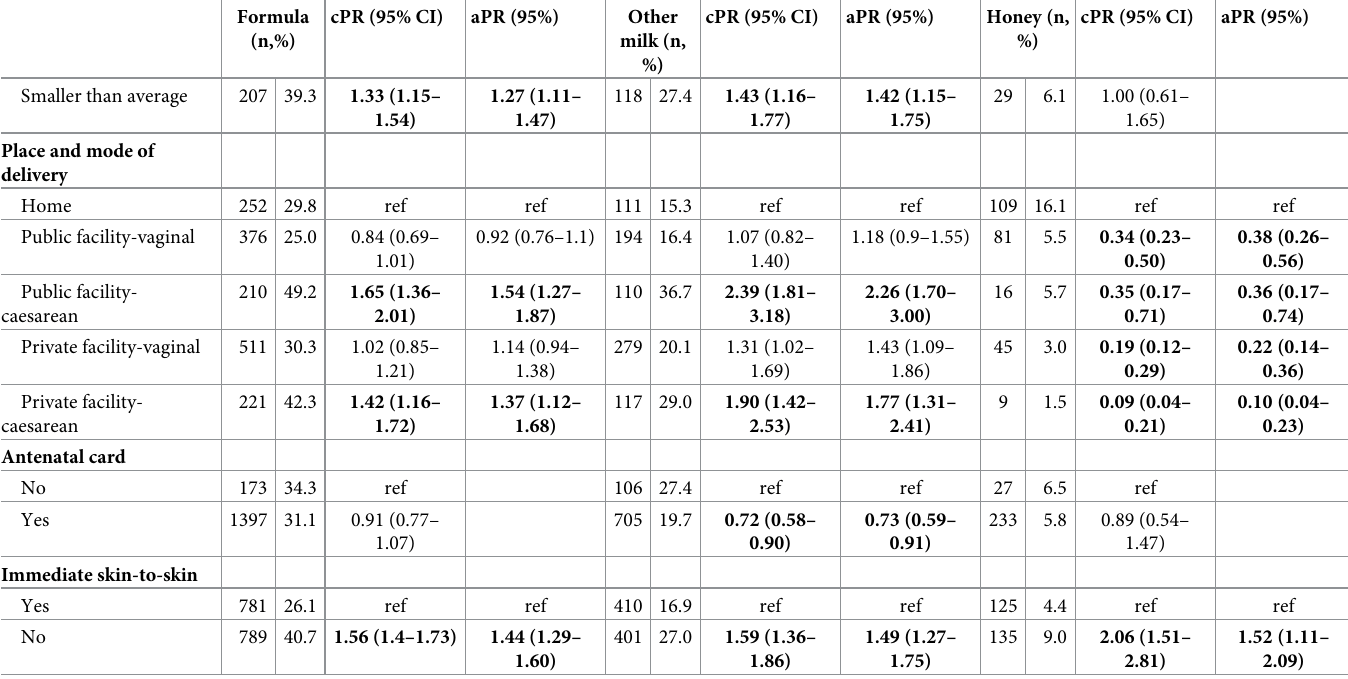
( � ) = wealth quintile as continuous variable; bold figure = statistically significant; n = unweighted count; % = weighted